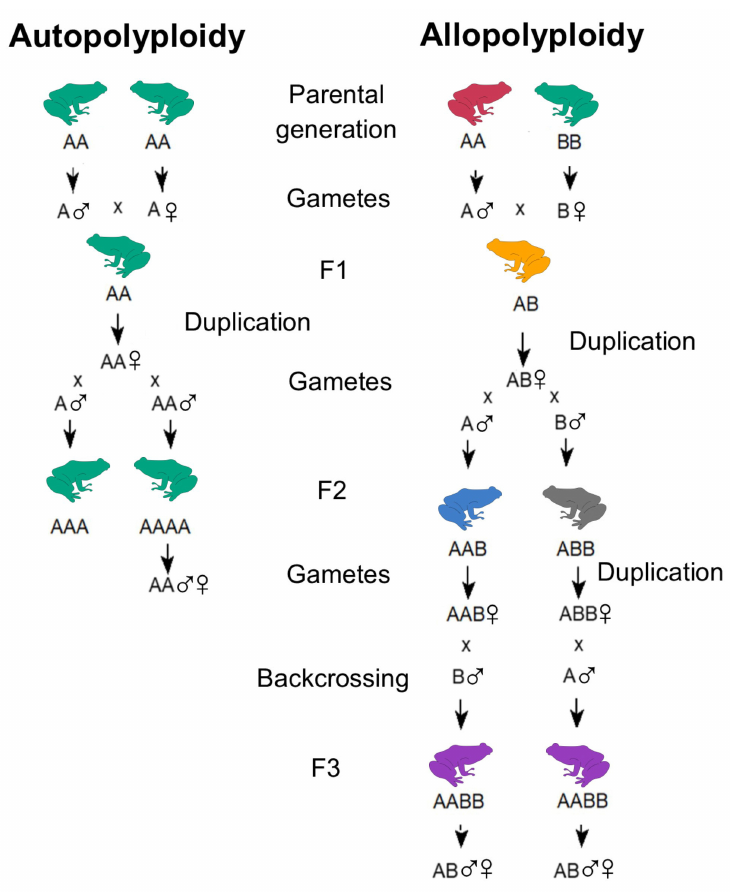
Figure 1. Schematic representation of autopolyploidy and